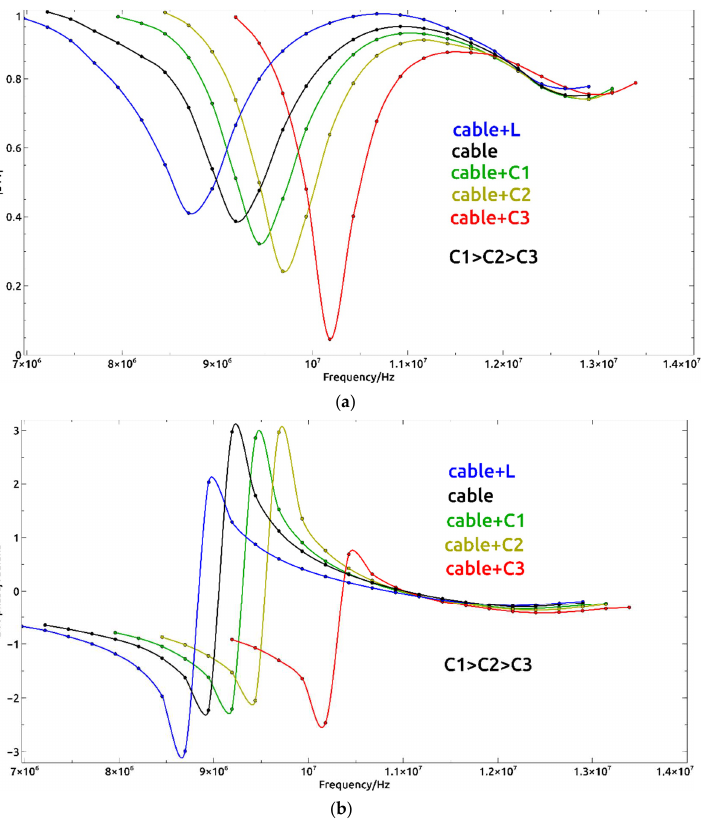
Figure 3. The shift of the loop resonance frequency with the addition of a reactance in series: the modulus ( a ) and phase ( b ) of the scattering parameter S11 measured with a VNA connected to the raw cable loop and with the addition in series of a coil and three increasing values of capacitors.